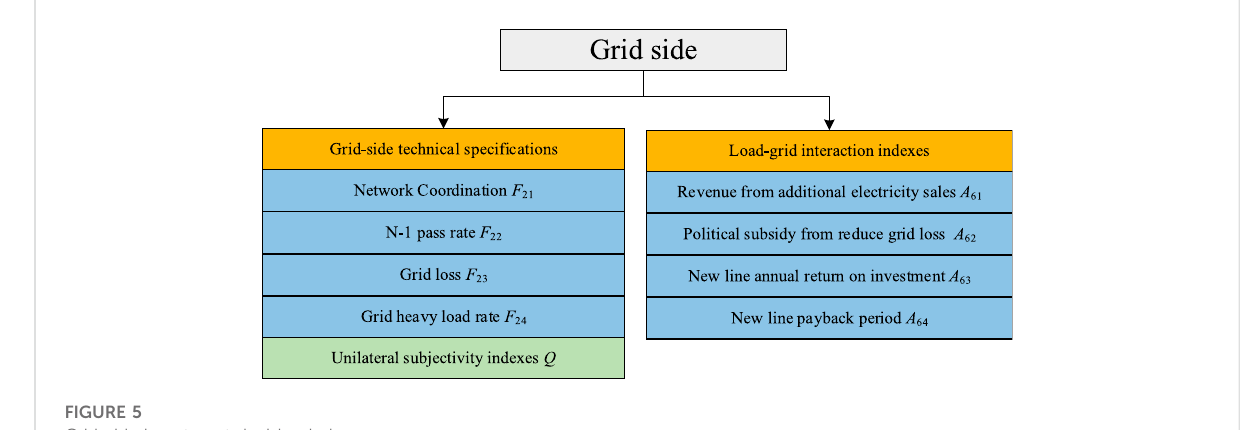
FIGURE 5 Grid-side investment decision